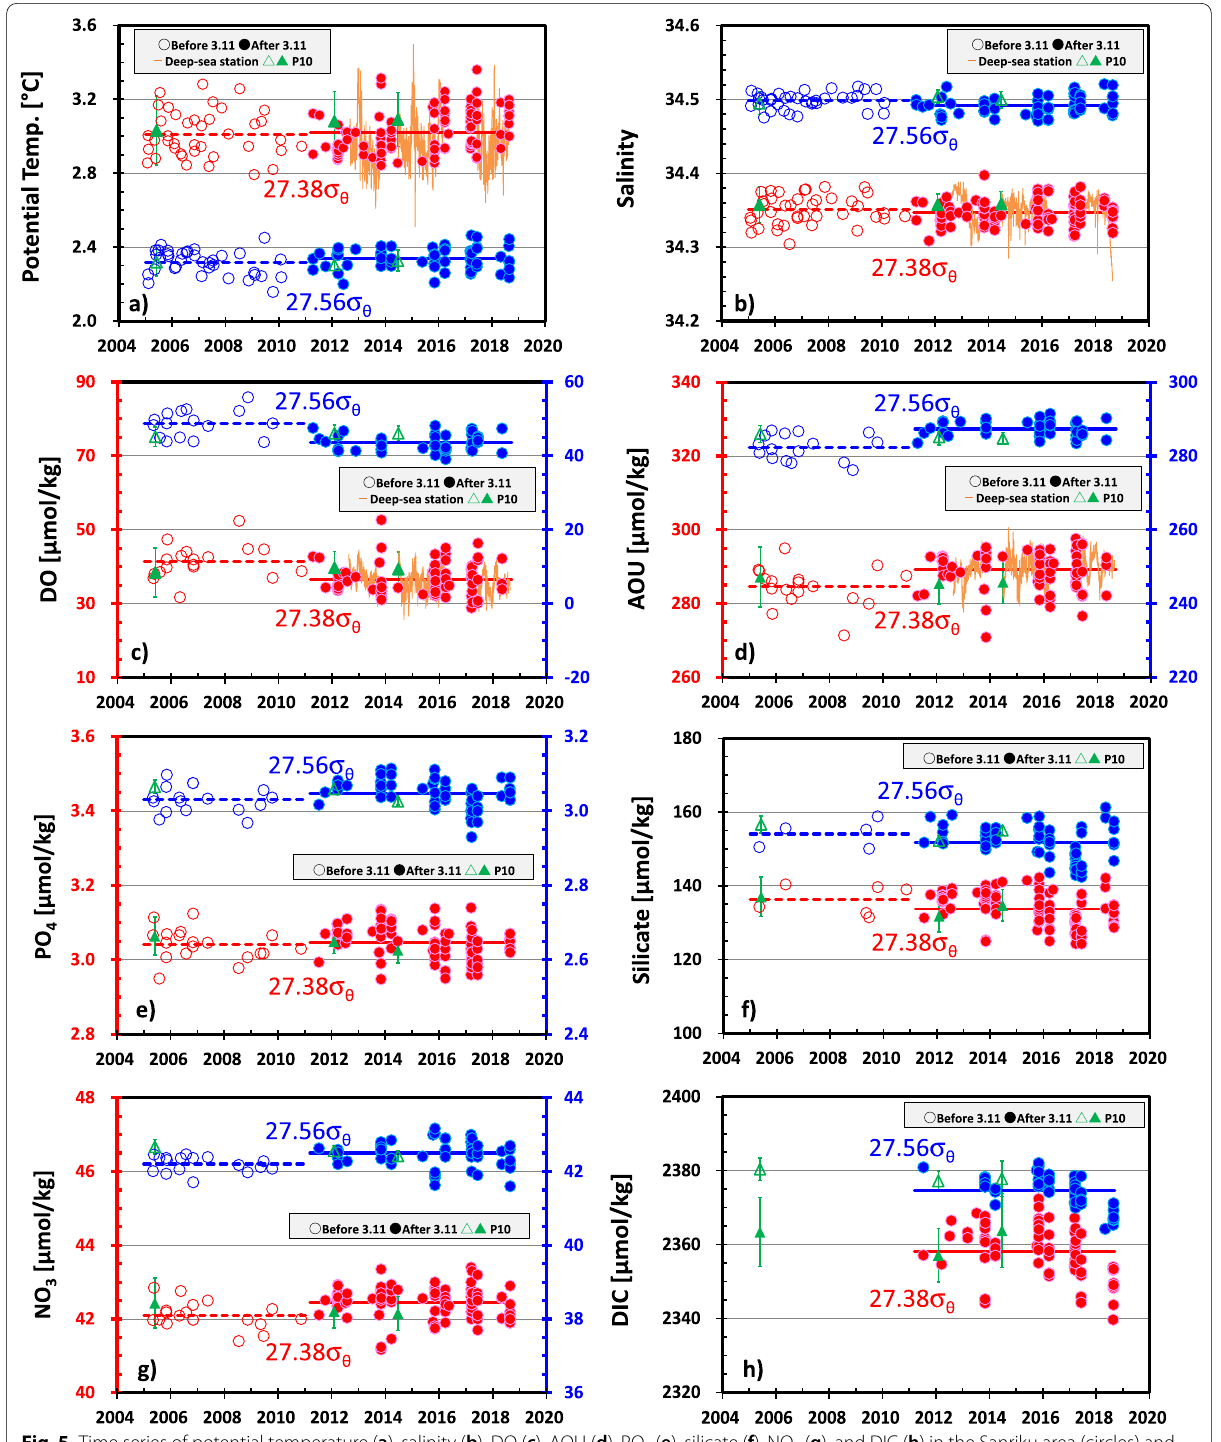
Fig. 5 Time series of potential temperature ( a ), salinity ( b ), DO ( c ), AOU ( d ), PO 4 ( e ), silicate ( f ), NO 3 ( g ), and DIC ( h ) in the Sanriku area (circles) and along the P10 section (green triangles) on the studied isopycnal surfaces (27.38σ θ : red; 27.56σ θ : blue). Open and closed symbols show values before and after the 2011 Tohoku Earthquake (3.11), respectively. In panels ( a – d ), thin orange lines denote values measured at the deep-sea station off Otsuchi Bay (Fig. 1a). Dashed and bold lines refer to mean values before and after the 2011 Tohoku Earthquake, respectively. Error bars are standard deviations for 2005, 2012, and 2014 along the P10 section, respectively. Right red (left blue) axes of DO ( c ), AOU ( d ), PO 4 ( e ), and NO 3 ( g ) denote the value on 27.38σ θ (27.54σ θ ),